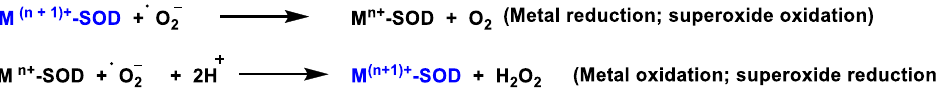
Figure 4. SOD-catalysed dismutation of the • O 2 − . where M = Cu (n = 1); Mn (n = 2); Fe (n = 2). In this reaction the oxidation state of the metal cation ranges between n and n + 1.